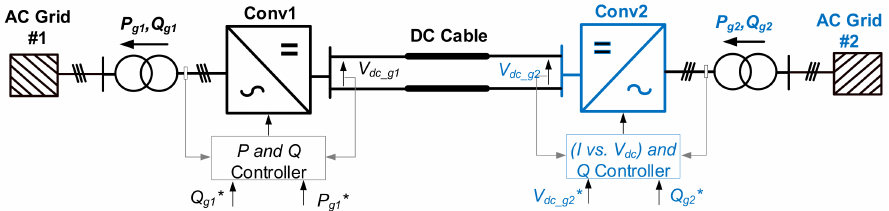
Figure 10. Two-terminal DC system with I vs. V dc droop and P control.